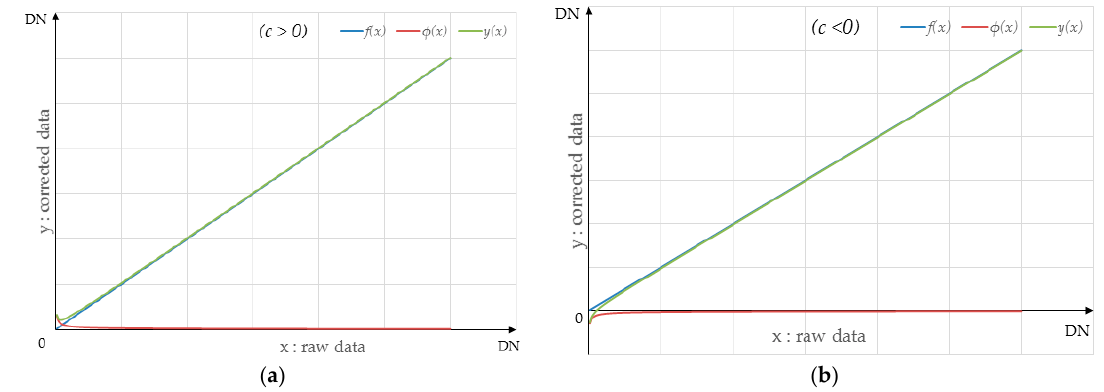
Figure 9. Simulation of the correction model with ϕ ( x ) set as the power-law function for: ( a ) c > 0; ( b ) c < 0. The blue line represents the linear transformation f ( x ) ; the red line represents the power-law function ϕ ( x ) ; and the green line represents the correction model y ( x ) . Figure 9a presents a